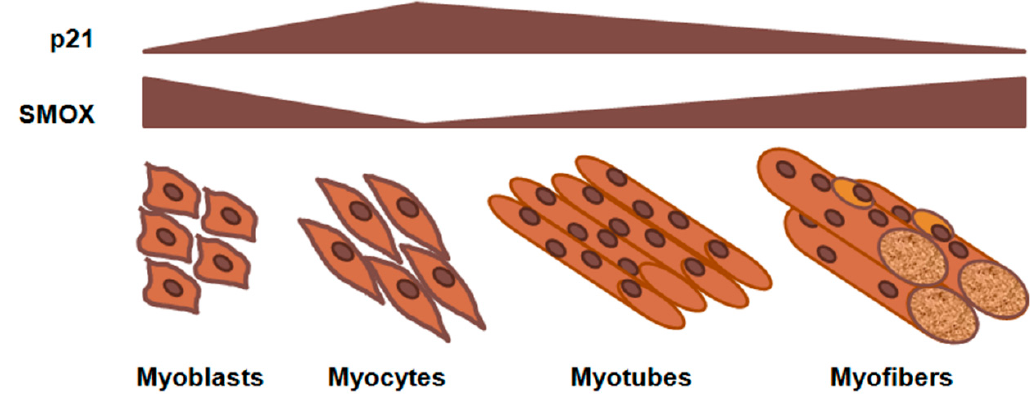
Figure 3. Hypothetical representation of SMOX regulation during myogenesis. During the early stage of muscle differentiation, p21 expression increases, leading to reduced SMOX expression. During the differentiation process, p21 declines in a time-dependent manner, allowing SMOX expression. Spermine oxidase catalyzes the direct back-conversion of Spm to Spd, 3-aminopropanal (3-AP), which is non-enzymatically converted to acrolein, and hydrogen peroxide (H 2 O 2 ) (Figure 4), and each of these products can affect muscle tissue in various ways, as described in the following sections.